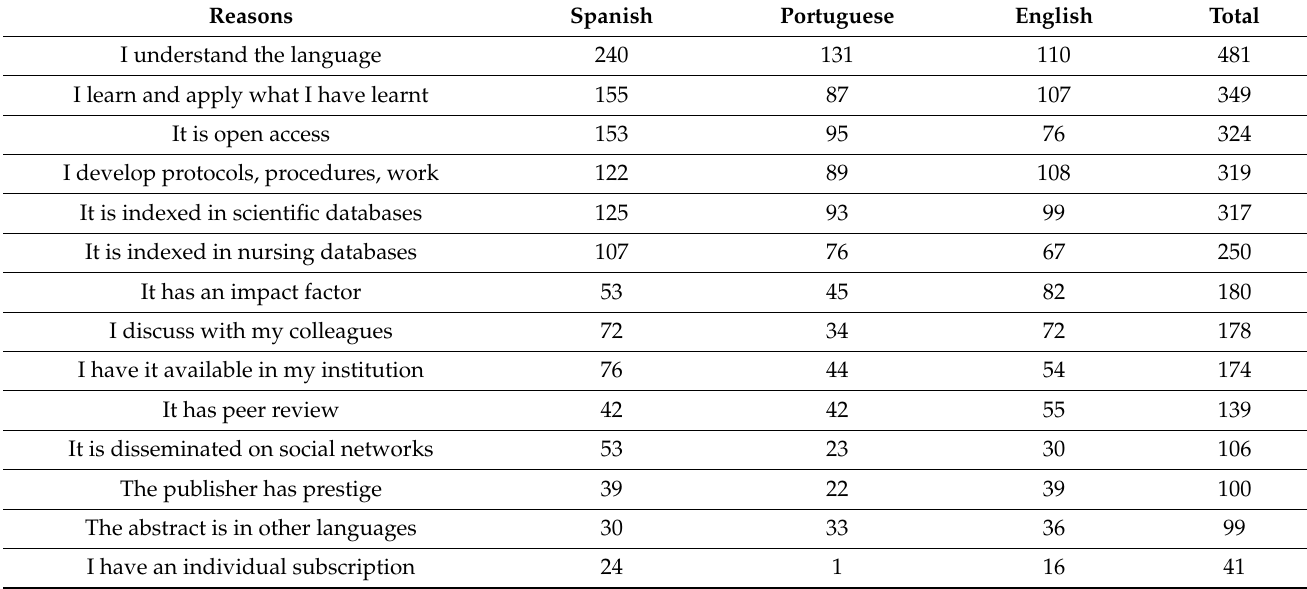
Table 3. 1Q_LcEE-CAPC Questionnaire. Reasons for reading journals, results, and reliability. Source: